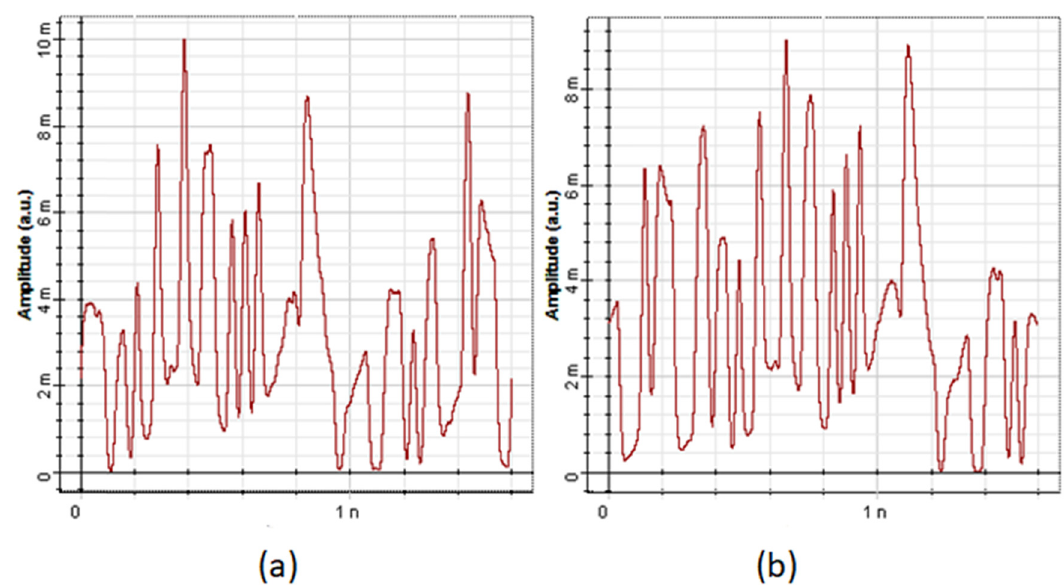
Figure 7: Amplitude vs time directly after Photodetector ( PIN ) at the side receiver for output: ( a ) signal_1 = 193.1 THz and ( b ) signal_4 = 193.4 THz @span = 200 km, and bitrate = 40